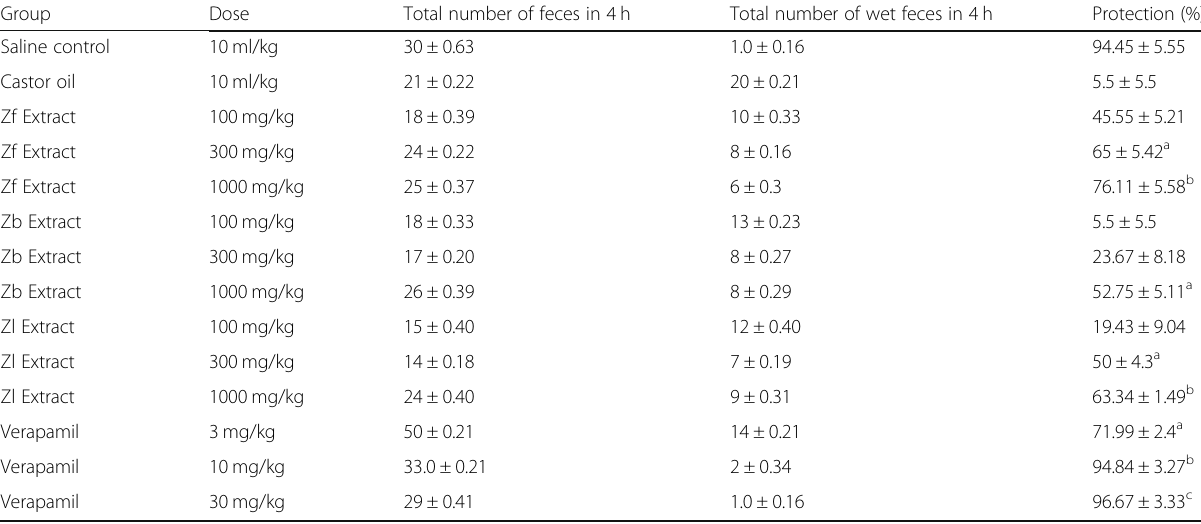
Table 1 Antidiarrheal activity of Z. armatum fruit, bark, leaves crude extracts, and verapamil